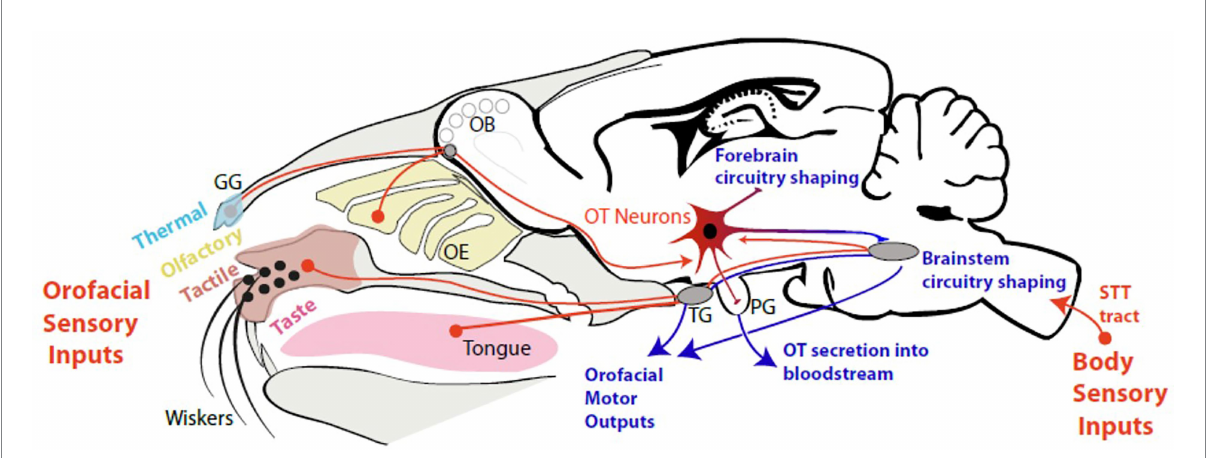
FIGURE 2 The oro-facial sensory inputs in neonates stimulate OT neurons. OB: Olfactory Bulb; OE: Olfactory Epithelium; OT: Oxytocin Neurons; GG: Grueneberg Ganglion; PG: Pituitary Gland; TG: Trigeminal Ganglion; STT: Spino-Thalamic